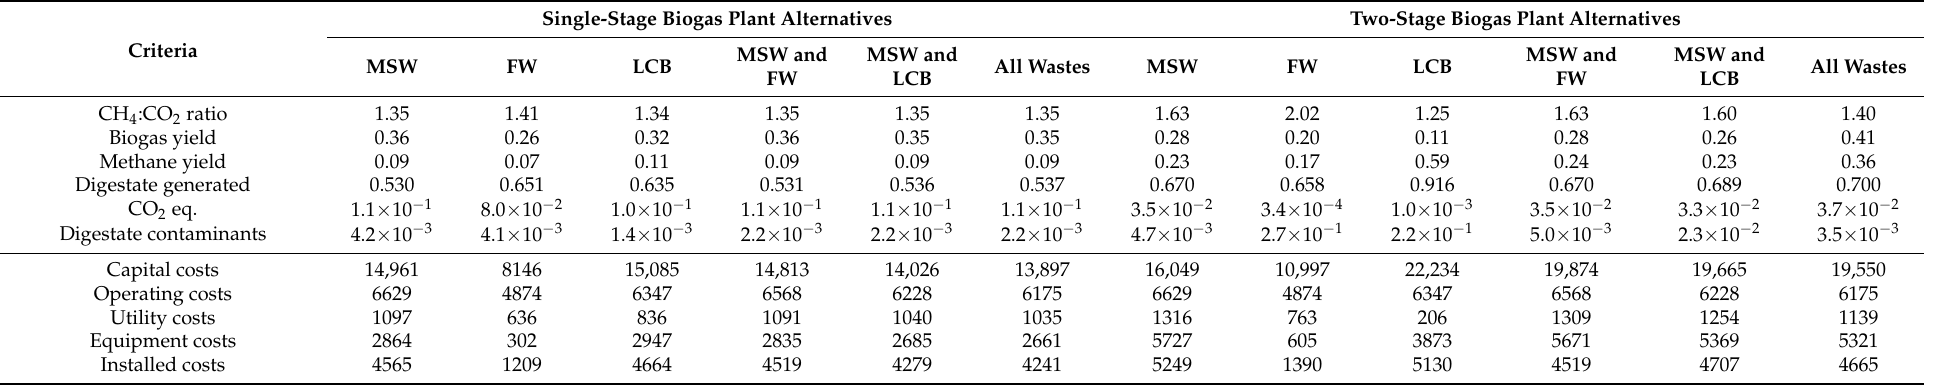
Table 3. Impact matrix for the MCA of the biogas plant alternatives introduced in the Definite